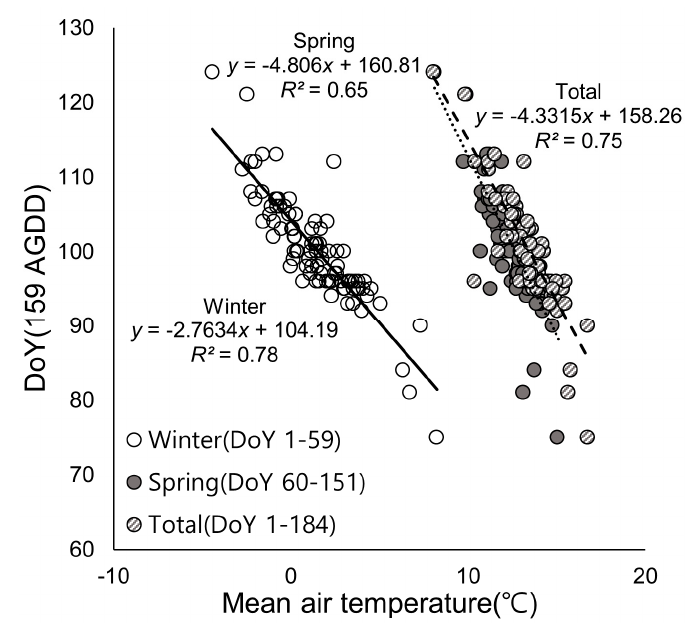
Figure7. Therelationshipbetweentheseasonalmeanairtemperaturesmeasuredfrom93meteorological Figure 7. The relationship between the seasonal mean air temperatures measured from 93 stations and the green-up DoY determined by the AGDD threshold. meteorological stations and the green-up DoY determined by the AGDD threshold.